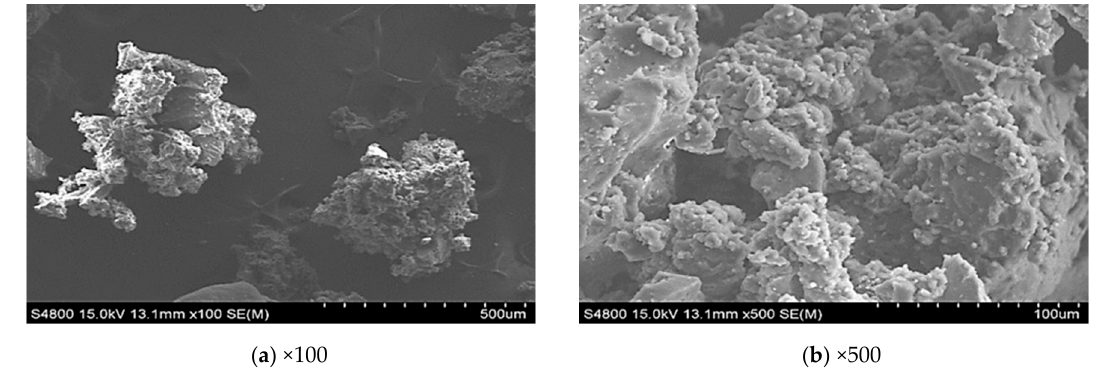
Figure 2. SEM image of the microwave activated crumb rubber (CR) particles.